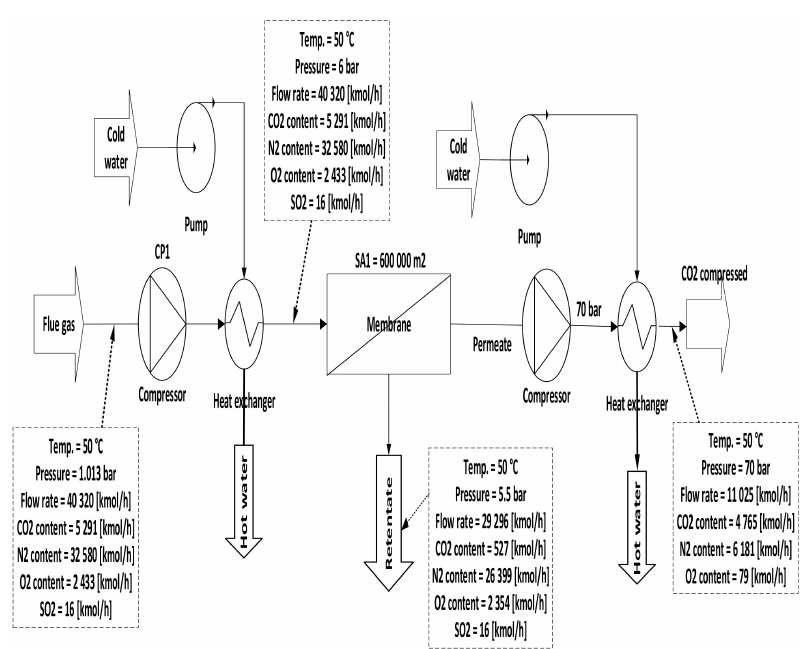
Figure 5. Single-stage scheme of a membrane with only a compression